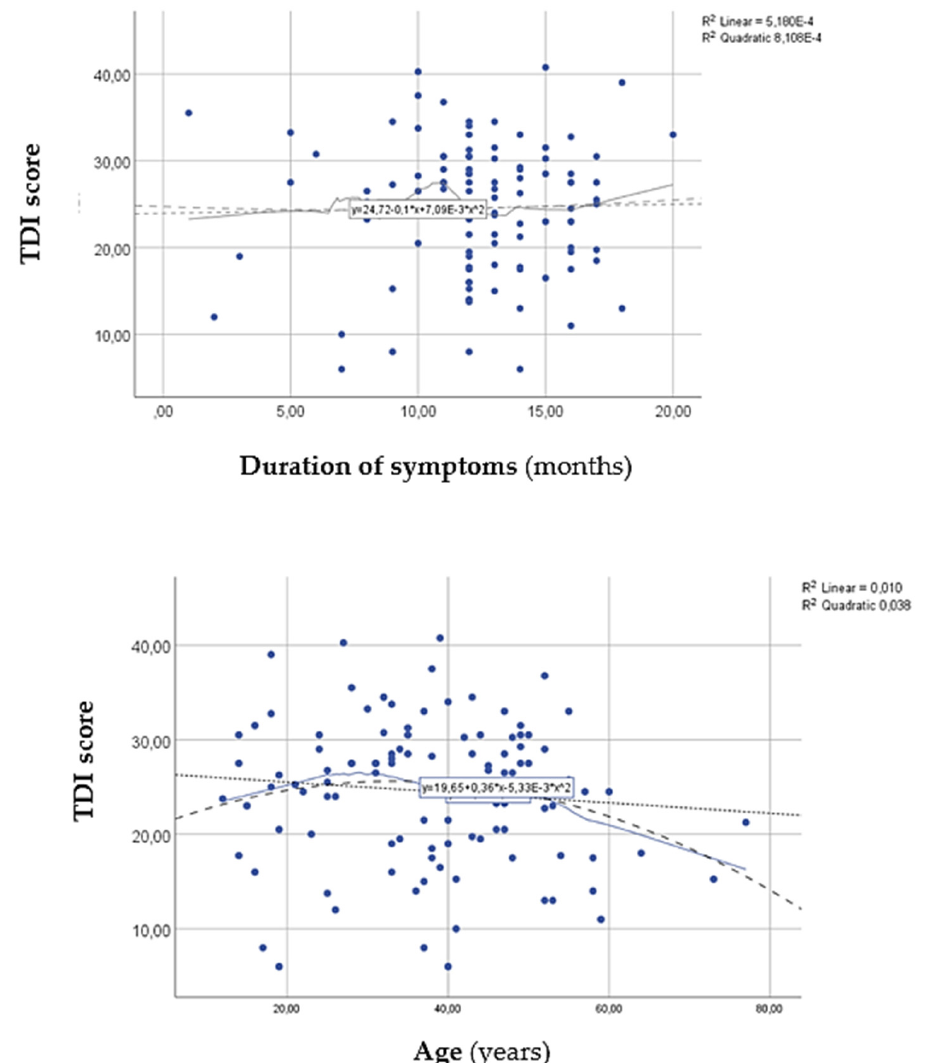
Figure 2. Correlation analysis between TDI and duration of symptoms and the participants’ age. Quadratic and linear regressions were used to analyse the relationship in the trends of the parameters (i.e., when age/duration is increasing, the TDI parameter is decreasing, or the contrary). The R 2 -values show the correlation coefficients, where a perfect correlation has an R 2 -value of 1. R 2 = coefficient of determination; TDI = Threshold, Discrimination, Identification.